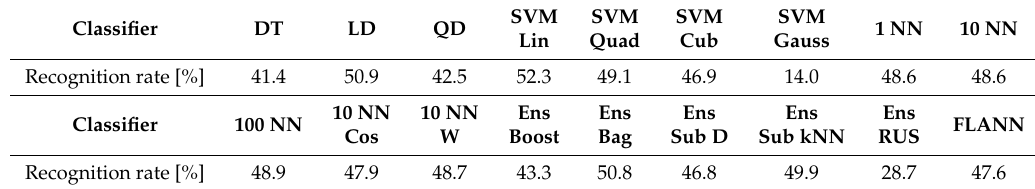
Table 6. Leave-one-subject-out cross-validation results for dataset 1, configuration (i), variant